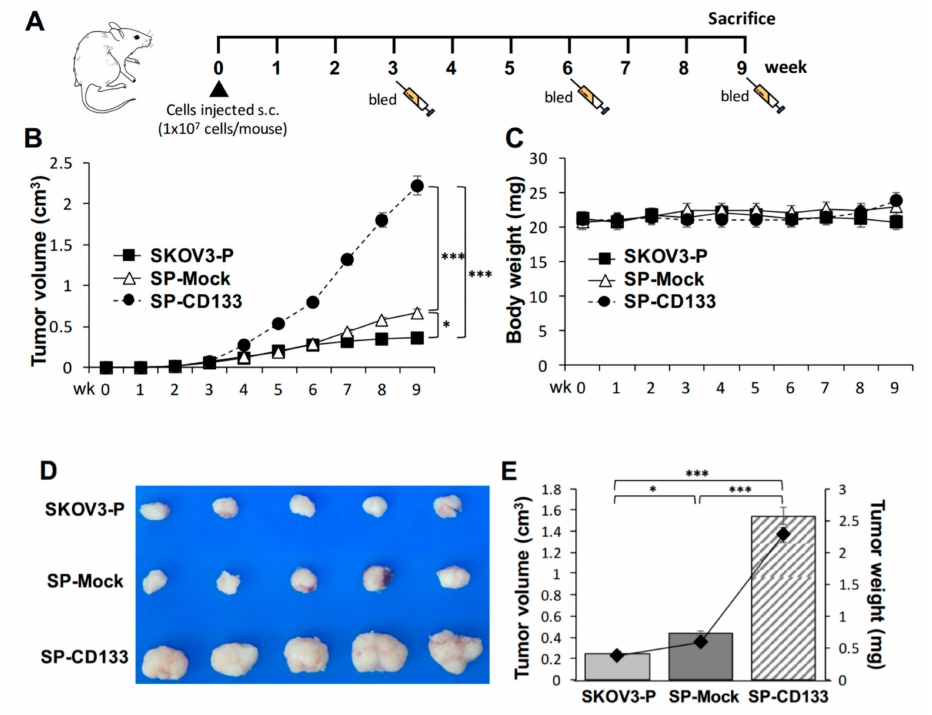
Figure 4. Cancer stem cell (CSC)-like SKOV3 spheres transduced with cluster of di ff erentiation 133 (CD133) promoted tumor growth in a xenograft mice model. SKOV3 spheres with CD133 transduction (SP-CD133), SKOV3 spheres with mock-transduction (SP-Mock), and parental SKOV3 (SKOV3-P) cells were subcutaneously (s.c.) implanted into NOD / SCID mice. ( A ) Detailed treatment schedule of the in vivo study is shown. ( B ) Tumor volumes (cm 3 ) during the subsequent period ( n = 6 per group; * p < 0.05; *** p < 0.001). ( C ) Body weights during the subsequent period. ( D ) Gross images of dissected tumors at the study endpoint. ( E ) Mean tumor volumes (cm 3 ) plotted in a bar graph, and mean tumor weights (mg) expressed in line plots from each mouse group at the study endpoint ( n = 6 per group; * p < 0.05; *** p <